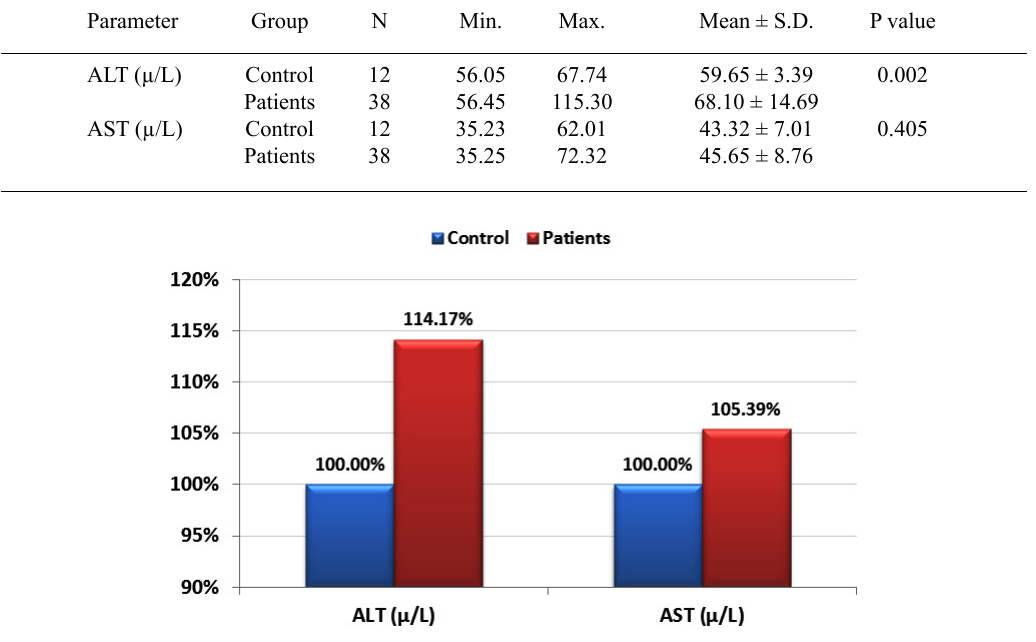
Fig. 1. Percentage change of ALT (µ/L) and AST (µ/L) in patients group compared to control group